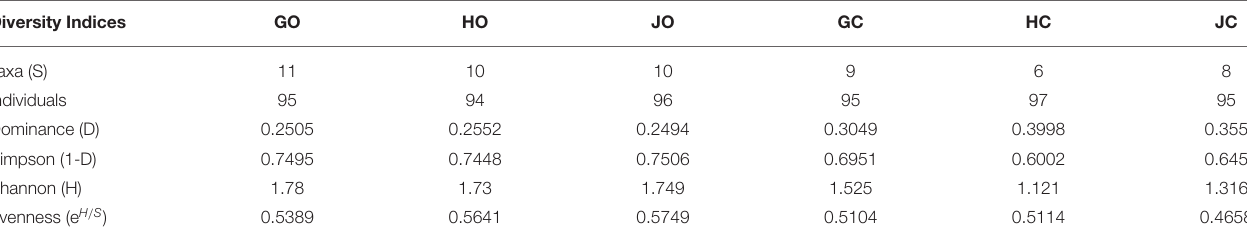
TABLE 5 | Diversity indices of bradyrhizobia isolates obtained from soybeans nodules grown in organic and conventional farms. Diversity